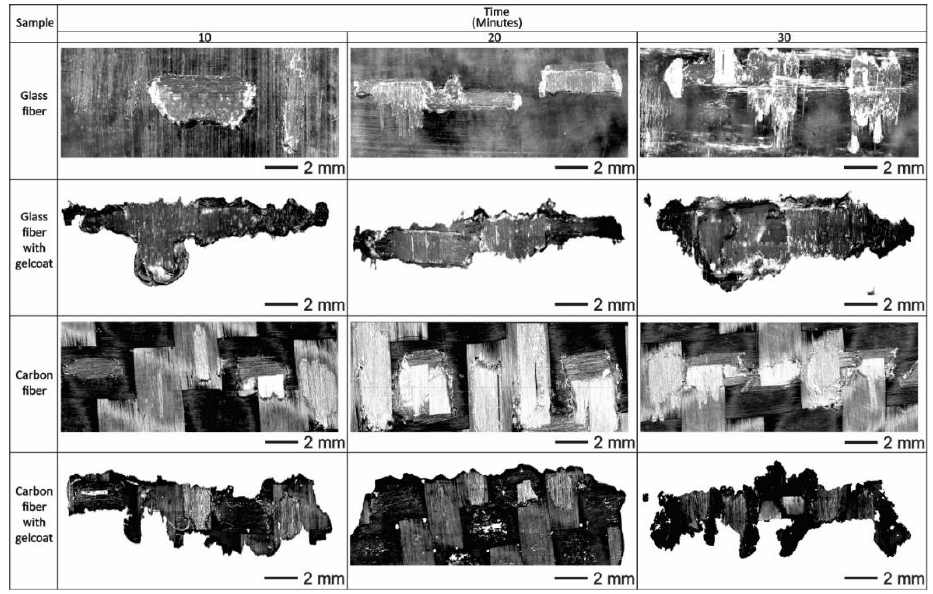
Figure 6. Damage of the surface of the samples using the test of liquid erosion at an impact angle of 75°.